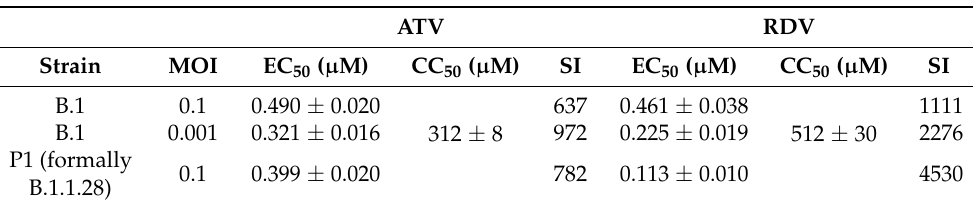
P1 (formally B.1.1.28)